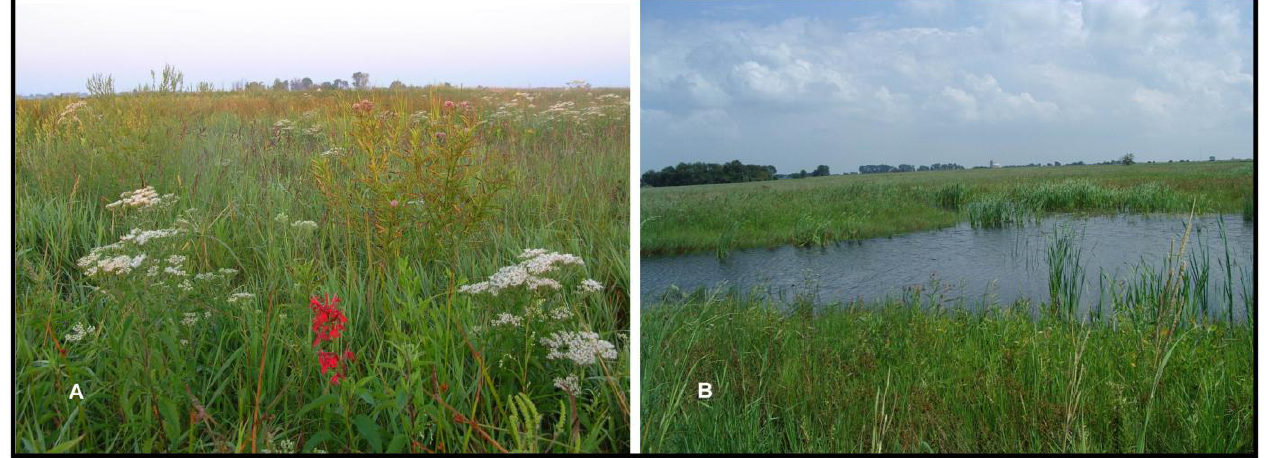
Figure 4. Two views of the restoration at Kankakee Sands demonstrating botanical diversity ( A ) and hydrologic complexity at the local scale ( B ). The restoration is explicitly designed to maximize ecological complexity as a strategy to increase potential habitat for r-d insects at the site, and to increase ecological resilience to potential climate